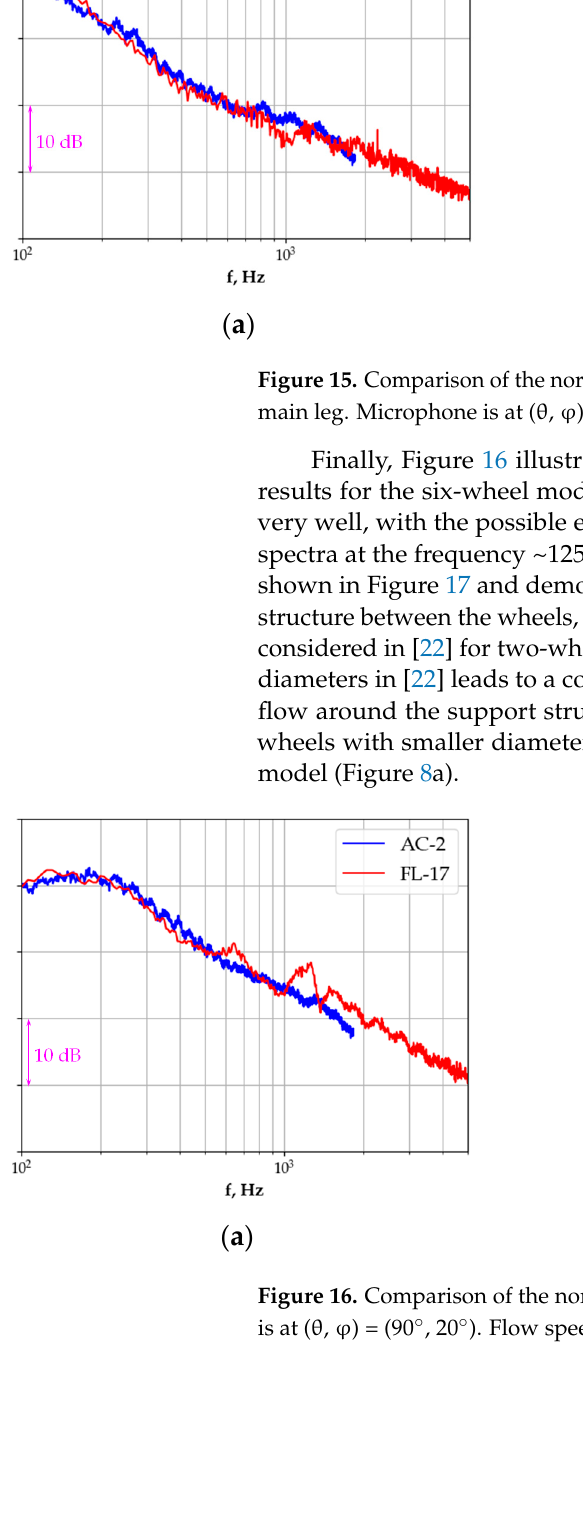
Figure 17. Localization of noise sources for the six-wheel landing gear model with high main leg. Flow speed is 75 m s − 1 ; frequency is 1250 Hz. In fact, it seems that while the results of small-scale tests agree reasonably well with the results of large-scale tests in terms of broadband noise of landing gear models, the small-scale tests fail to predict the tonal noise that appeared for some landing gear con- figurations in FL-17 CARDC. An example of this situation is shown in Figure 18 for the two-wheel landing gear model. ( a ) ( b ) Figure 18. Comparison of the normalized spectra of the two-wheel landing gear model with high main leg. Microphone is at ( θ , φ ) = (90°, 20°). Flow speed is ( a ) 75 m s − 1 , ( b ) 34 m s − 1 .